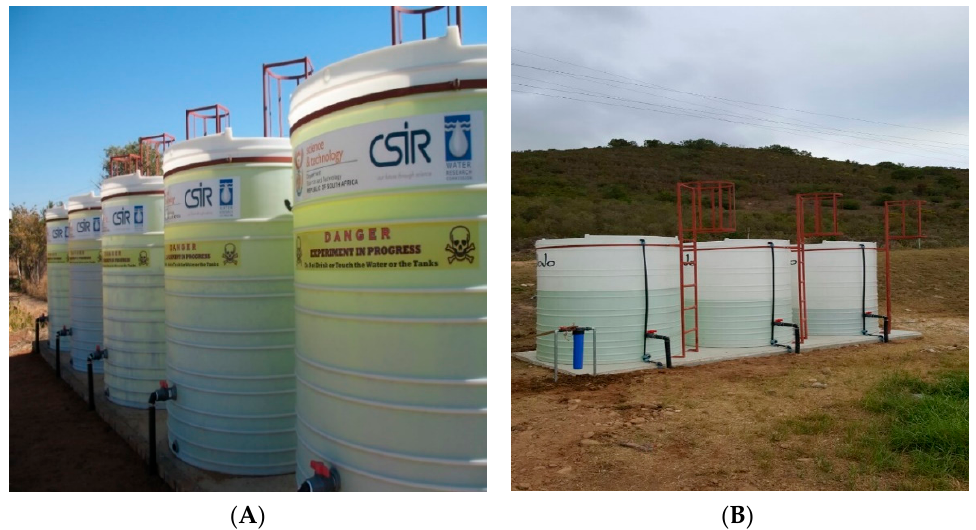
Figure 2. Photobioreactors for the outdoor mass culturing of the consortium of specific microalgae at the Motetema ( A ) and Brandwag ( B ) municipal WWTP systems.